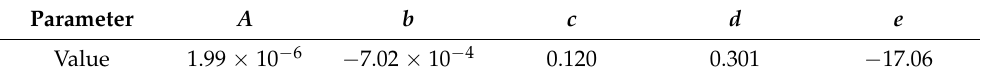
Table 1. Values of the parameters of Equation (7), calculated from the training data set.